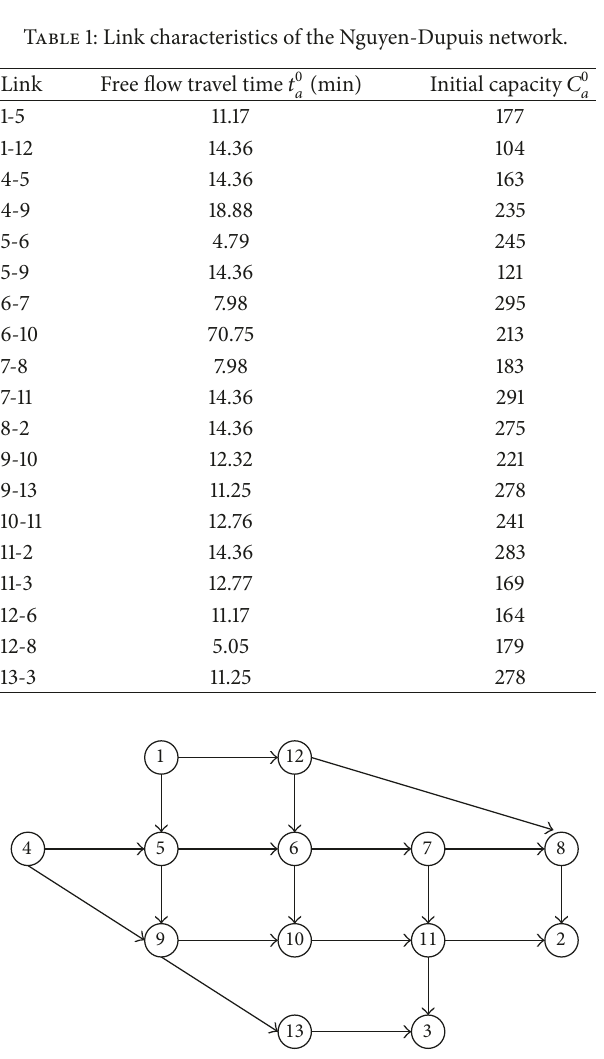
Figure 5: Nguyen-Dupuis